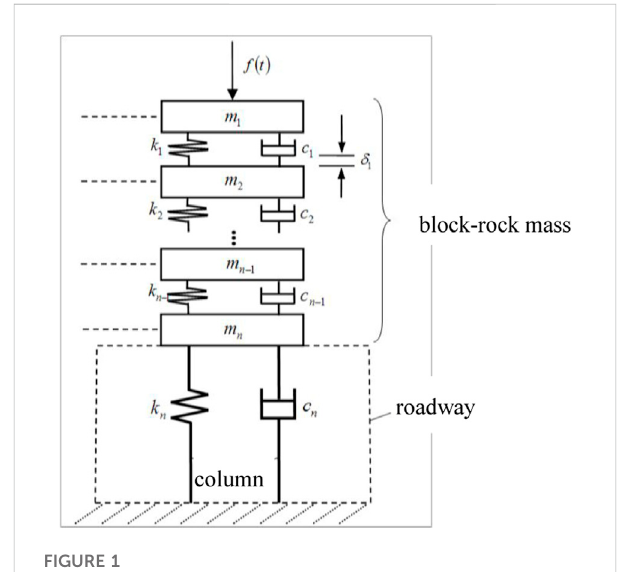
FIGURE 1 Dynamics model of surrounding rock-column system in the